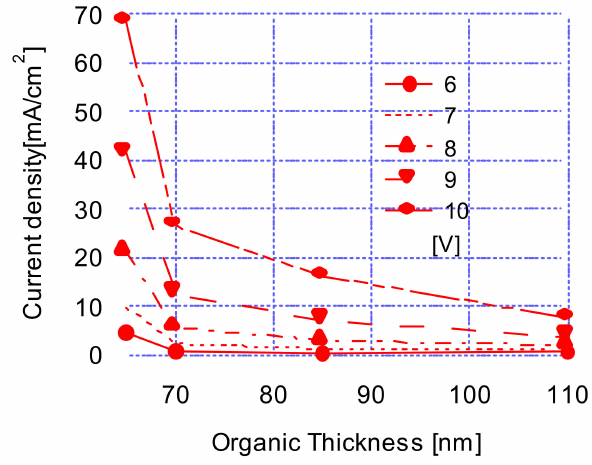
Figure 3. Current density characteristics as a function of organic thickness (emission layer and hole transport layer) at various operating voltages.